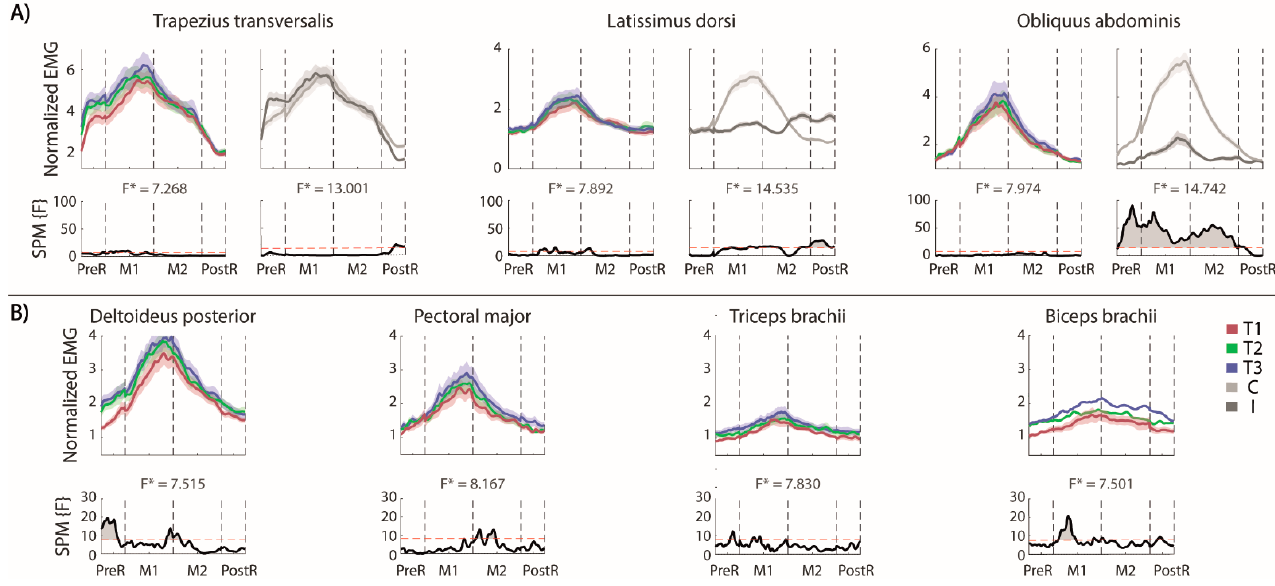
Figure 4. MFRT in the lateral direction ( A ) bilateral EMG activity of the trunk muscles: for each pair of muscles we reported the envelops (top) and the statistical analysis (down, the significance difference is the part of the curve above the dashed red line) separated for the trials’ repetition (left, the mean activity of the muscles pair is reported in red, green and blue for T1, T2 and T3, respectively) and the side (right, the mean activity of each side is reported in lighter and darker gray for the contralesional and the ipsilesional side, respectively); ( B ) EMG activity of the contralesional arm muscles separated for the trials repetition and the statistical analysis (bottom). F* is the F* value from the statistical analysis.